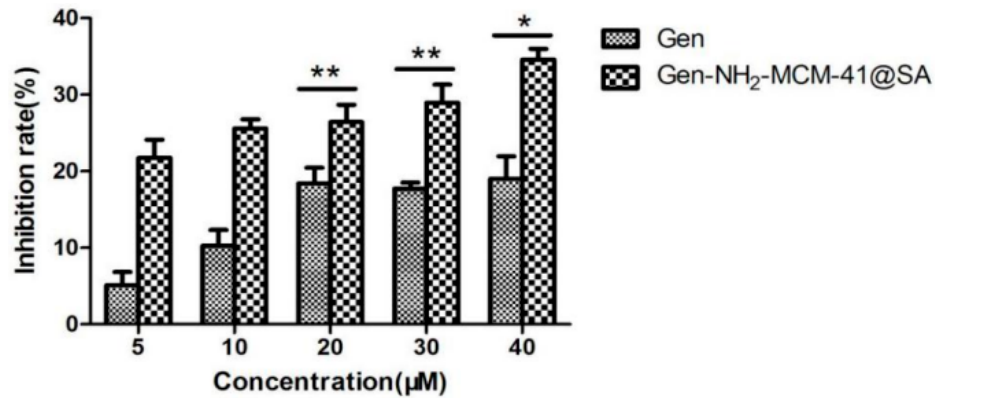
Figure 15. Gen-NH 2 -MCM-41@SA and Gen inactivation RV-Wa (* p < 0.05, ** p < 0.01).